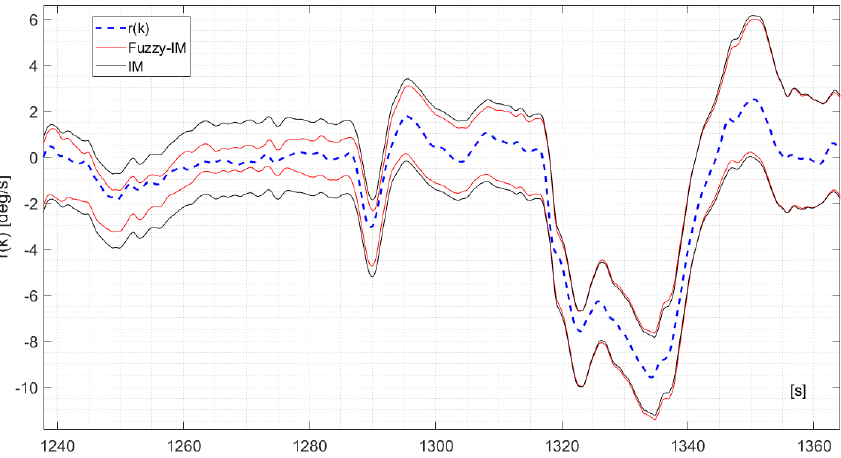
Figure 6. The measured r ( k ) signal and the time varying upper bounds r ( k ) and lower bounds r ( k ) derived for the IM applying Equation (18) and for the FIM applying Equation (20).